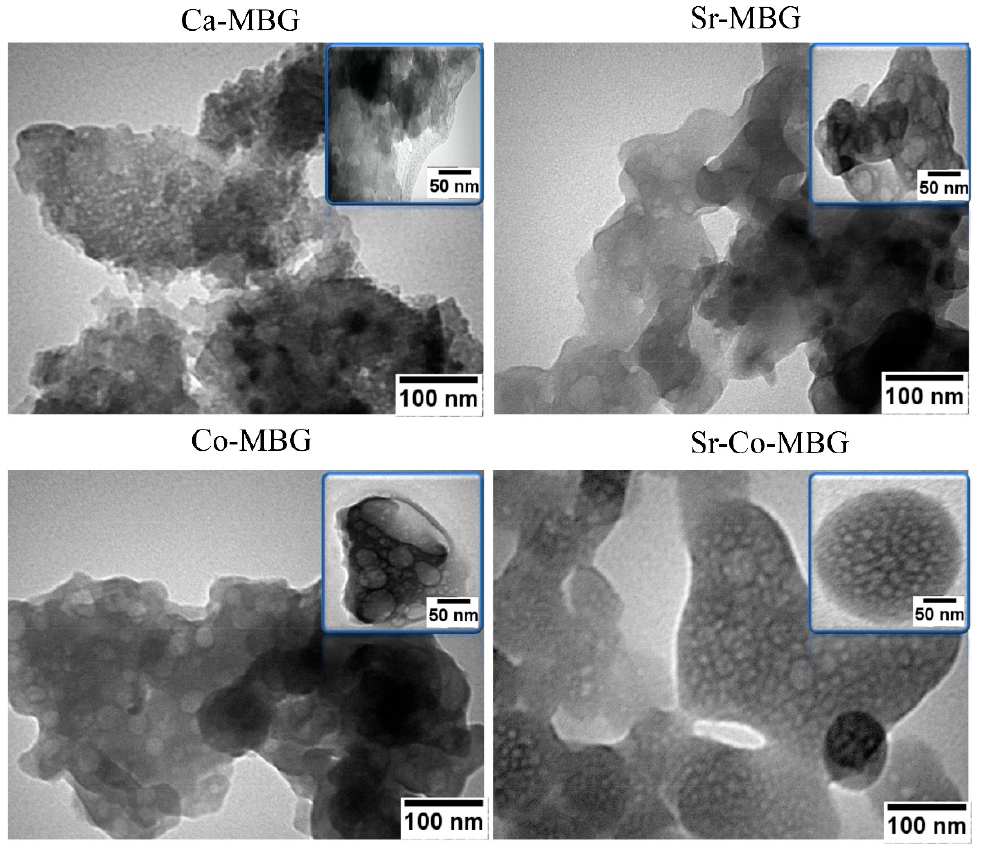
Figure 6. TEM analyses on the as-produced samples.